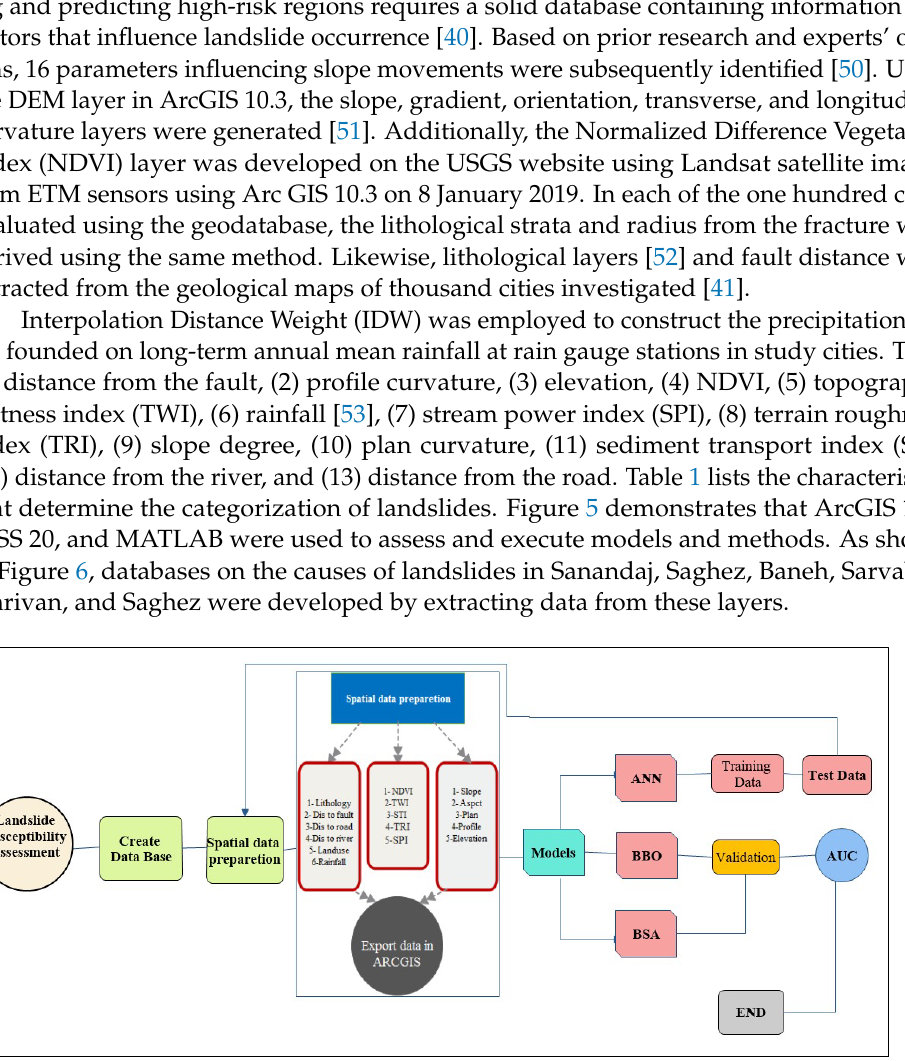
Figure 5. Methodological process of the applied model for measuring susceptibility landslides as- sessment.